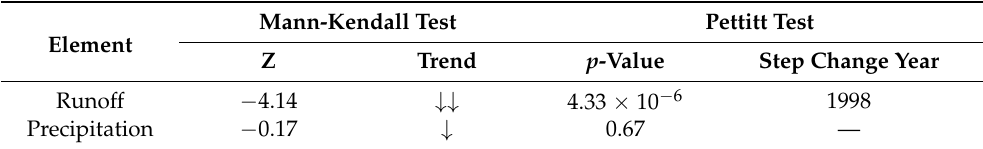
Table 3. Results of Mann-Kendall trend test and Pettitt test for the annual precipitation and runoff series over the Xilin River Basin in the period of 1975–2019.